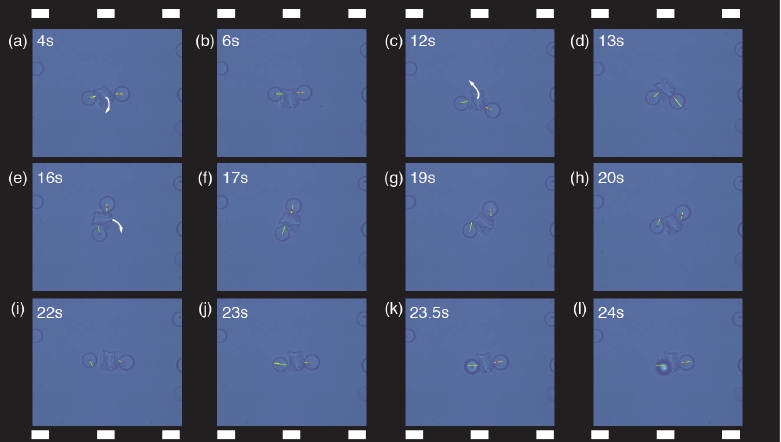
Figure 4. Video frame sequence of the cooperative indirect micromanipulation of a glass fragment, with the reaction forces and their directions at each contact position of the end-effectors (7.8 µ m microbeads) superimposed by yellow lines in real time. In each snapshot, the movement direction of the fragment during cooperative manipulation is indicated by a white arrow. The images are also shown in Supplementary Video